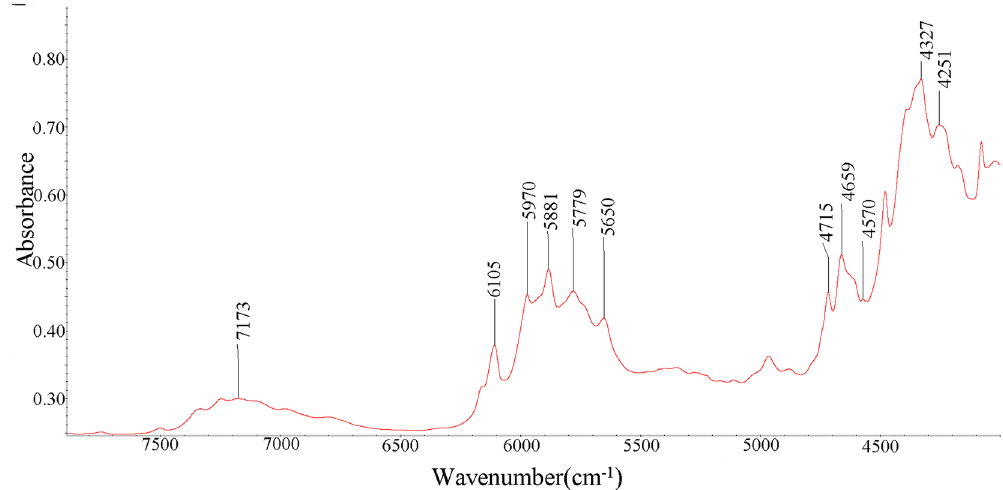
Figure 6: NIR spectra of the prepreg